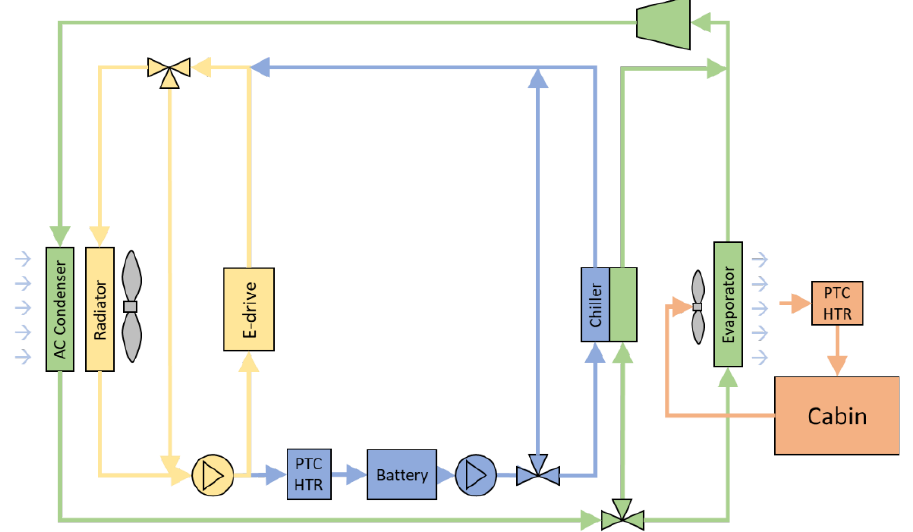
Figure 3. Integral thermal management system of the electric bus: Connected configuration.